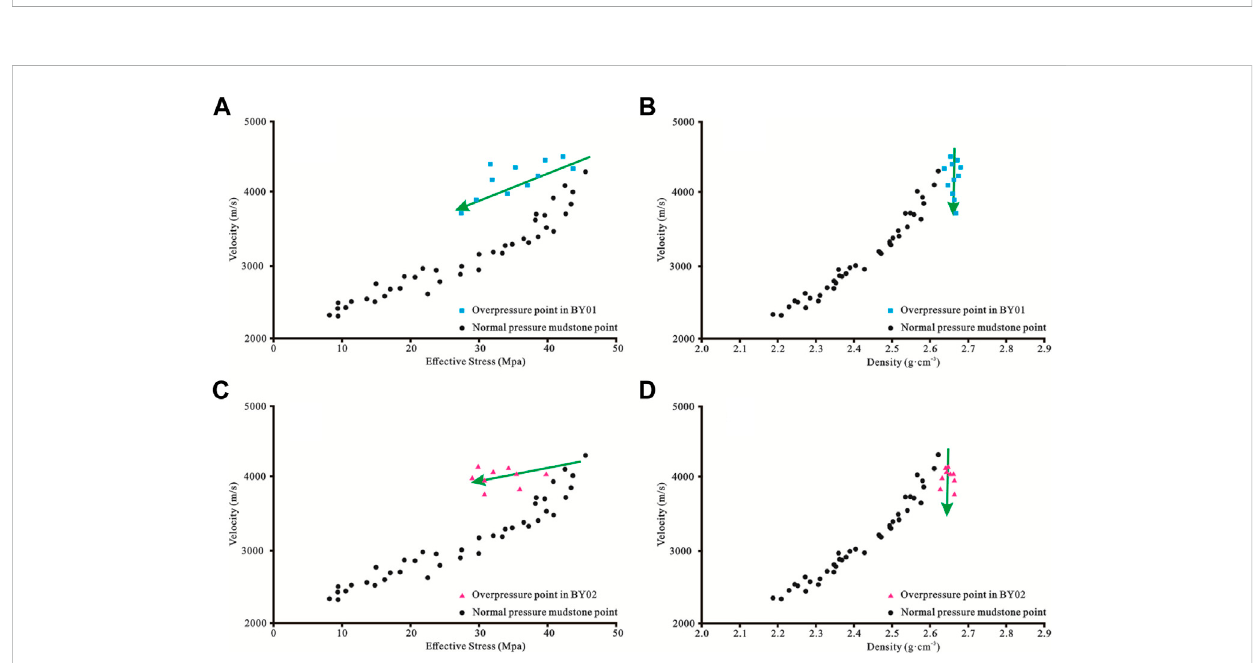
FIGURE 8 The genetic mechanism of overpressure is identi fi ed in Baiyun Sag, the plate according in Bowers (1995). (A,B) drop point results of Paleogene mudstone data in Well BY01. (C,D) drop point results of Paleogene mudstone data in Well BY02.